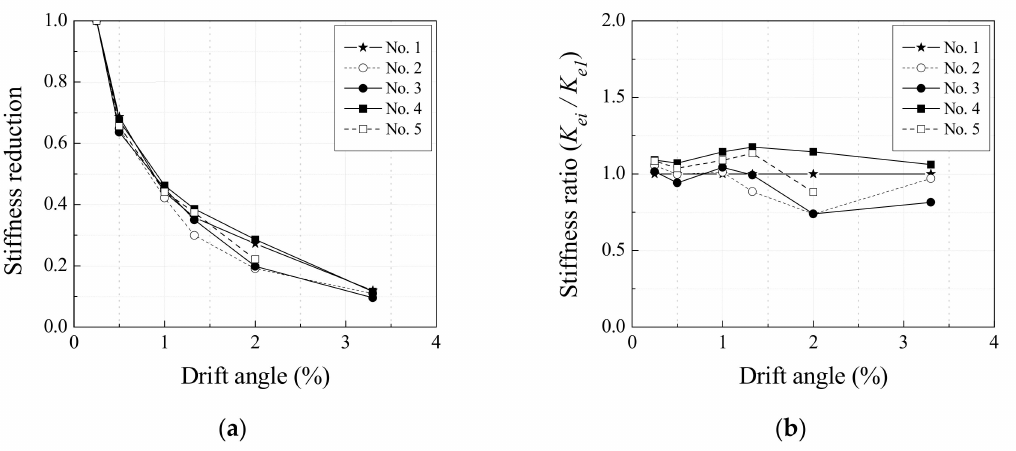
Figure 7. E ff ective sti ff ness of specimens with respect to drift angle: ( a ) sti ff ness reduction; ( b ) sti ff ness